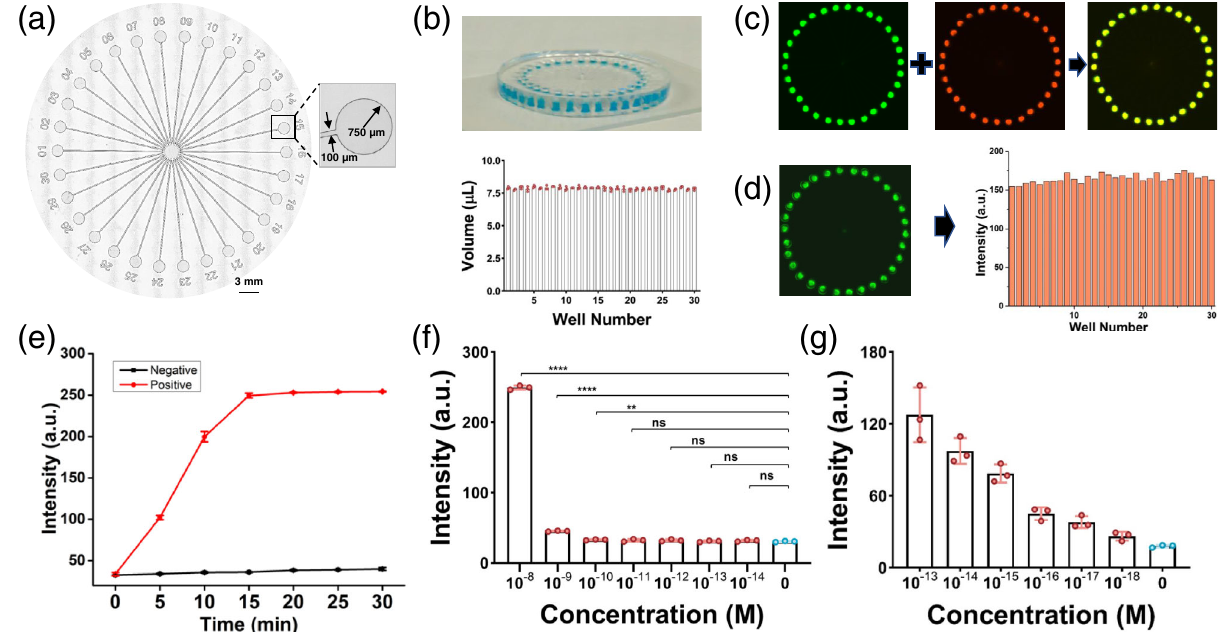
Fig. 5 | Evaluation of SS-Chip performance. a Stitched microscopic image showing the microchannels and wells of the SS-Chip, with labels. b Photograph of the device fi lled with blue food dye to mimic the sampling (top), and the corre- sponding quantitative analysis of the volume in each outlet (bottom). c Stitched fl uorescenceimagesshowingthesolution mixing performanceof the SS-Chipwith fl uorescein (green) and sulforhodamine B (red). d Stitched green fl uorescence image and the corresponding intensity analysis of Cas12a-based HPV-16 testing. Source data are provided as a Source Data fi le. e Kinetics of